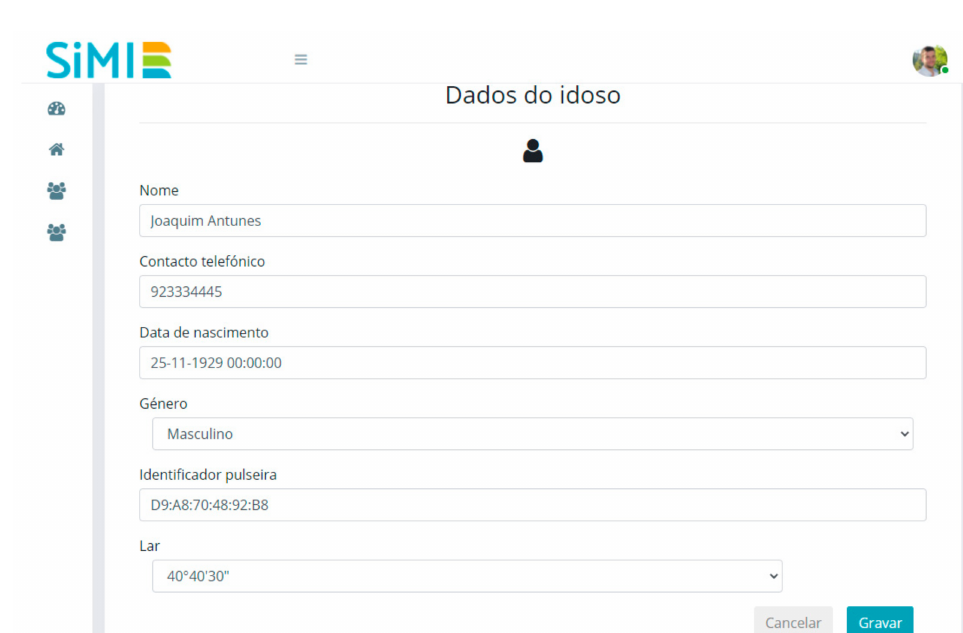
Figure 12. The elderly’s editing page.